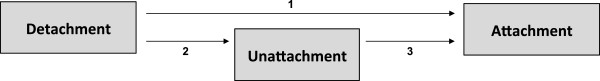
The Transitioning Trajectory. The transitioning trajectory consists of two or three phases. Patients who detach and immediately source an available family physician go directly from detachment to attachment (1). Patients who spend a period without a physician while searching for a one pass through unattachment en route to attachment (2). For this group attachment can only be achieved if a new regular physician is sourced (3).